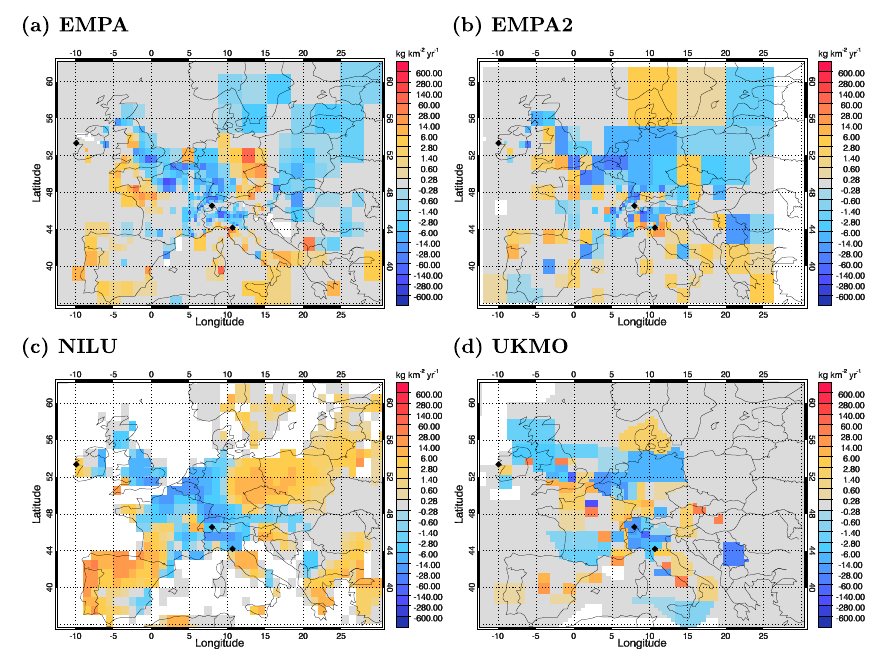
Figure 7. Posterior–prior HFC-134a emission differences (experiment M2).